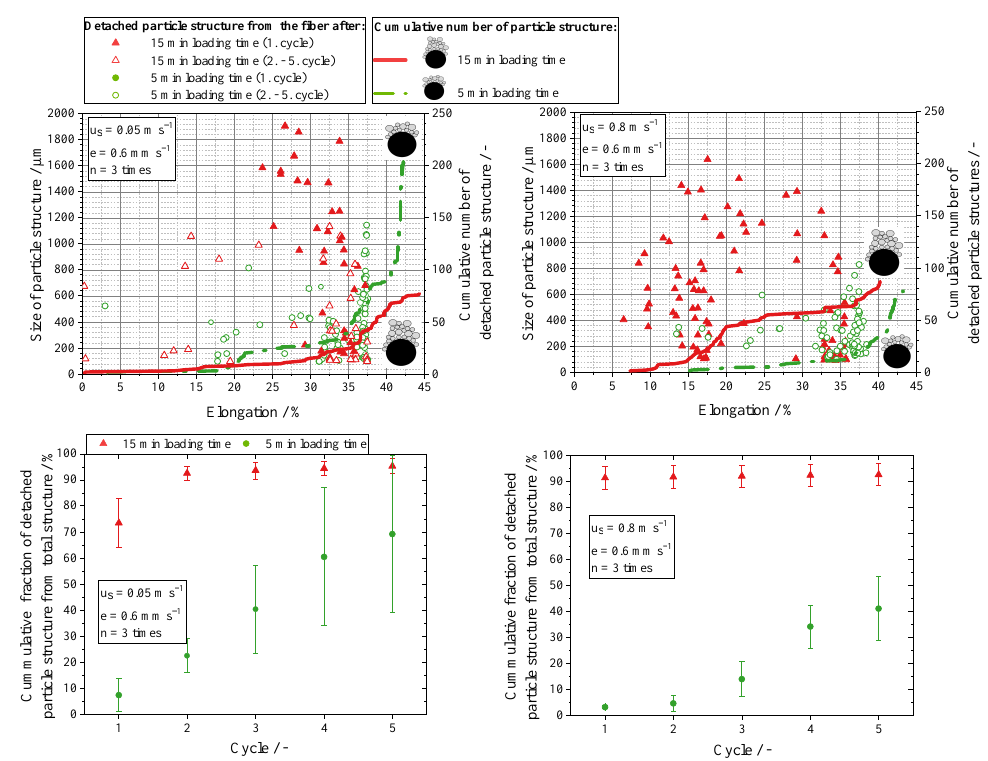
Figure 7. ( TOP ) Size and cumulative number of detached particle structures measured with the LSDS during the five cycles of fiber stretching, comparing low (5min loading time, green) and high (15min loading time, red) particle loading of the fiber for two superficial velocities ( u s = 0.05ms − 1 , left and u s = 0.8ms − 1 , right, respectively). ( BOTTOM ) Cumulative fraction of the detached parti- cle structures from total particle structure determined with image analysis during the 5 cycles of fiber